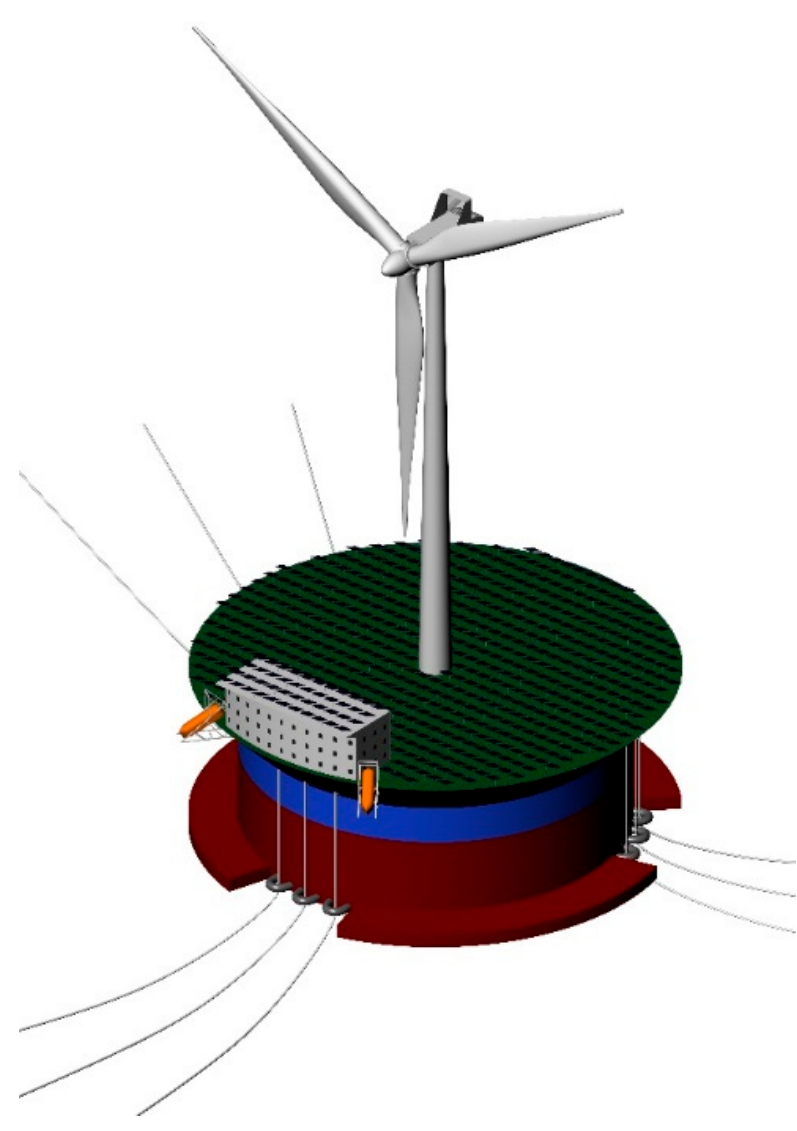
Figure 1. Proposed floating desalination plant (FDP) concept.